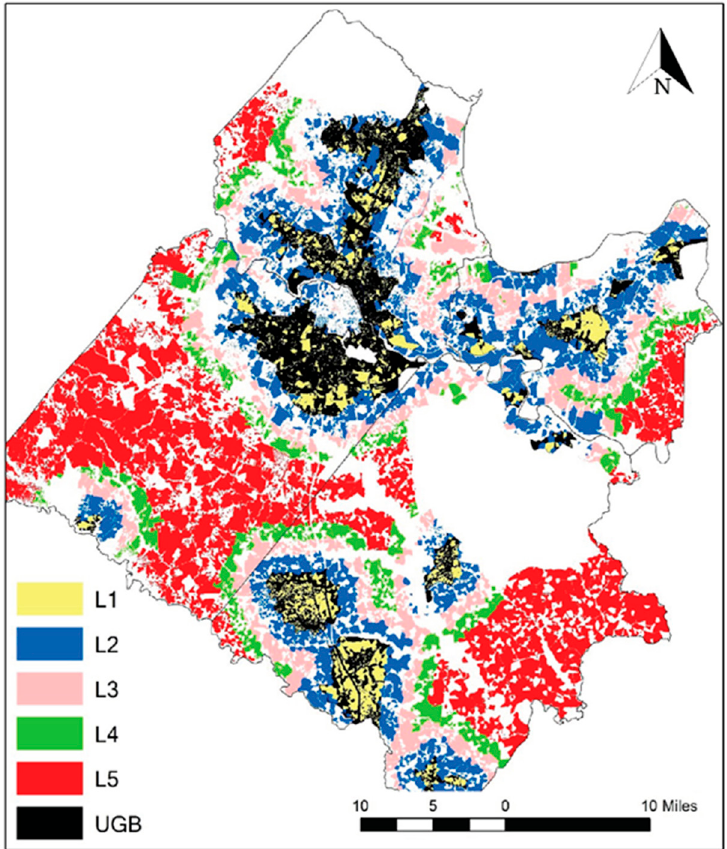
Figure 6. Land Development Scenarios with Buffers around UGBs.